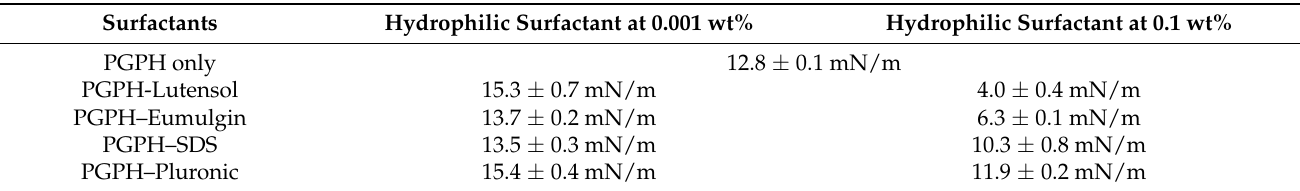
Table 3. Interfacial tension values at a MCT–water interface interacting PGPH at 0.1 wt% with hydrophilic surfactants at different concentrations.